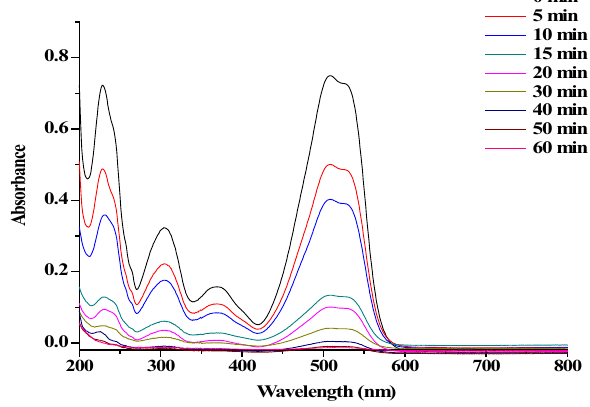
Fig. 8 UV–Vis absorption spectra showing Chromotrope 2R oxida- tion (C2R: 2.0 × 10 −4 mol L −1 ; H L −1 ; 60 °C, normal pressure, and 180 rpm